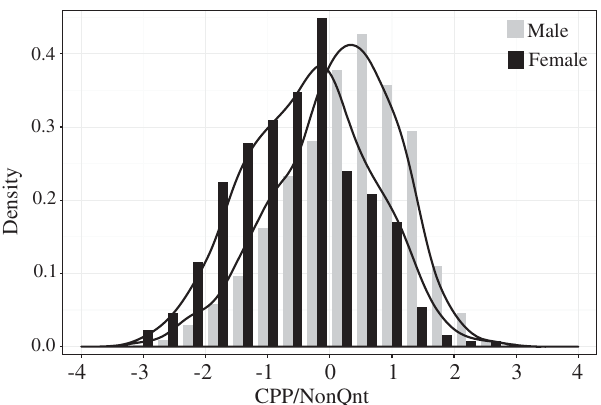
FIG. 4. Structural equation model for CPP/NonQnt ’ s relation to qualitative problem performance. The rectangles represent mea- sured variables and the oval an unmeasured latent variable. The weighting of lines between observed variables are the linear regression coefficients. The weighting of lines between latent and observed variables are the factor loadings. The curved lines represent the variance in each variable.